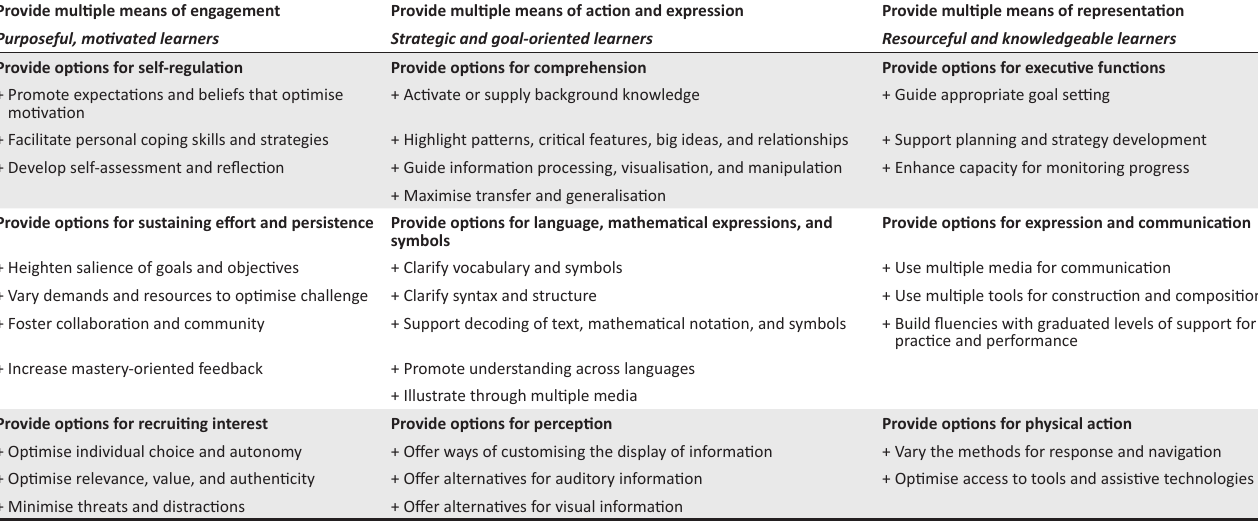
TABLE 1: Three principles of universal design for learning. Provide multiple means of engagement Provide multiple means of action and